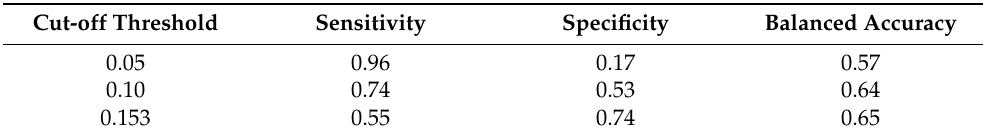
Table 4. Five hypothetical subjects with their predicted probability of having a CAGE score ≥ 2. The optimal cut-off was set at 0.153. The first two subjects approximately achieved this predicted